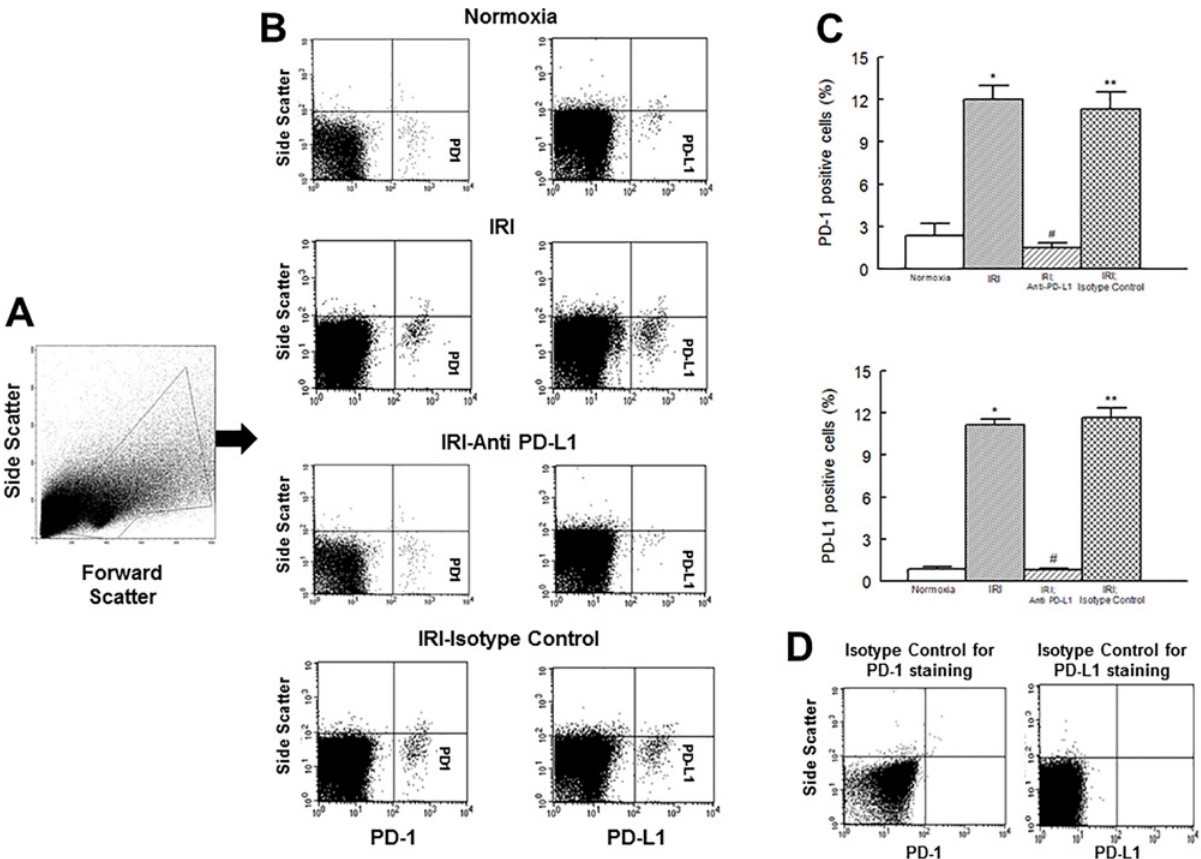
Fig 1. Flow cytometry profile of cardiac cell preparations outlining gated events is shown under panel A. Representative flow cytometry dot plots, under panel B, show increased expression of PD-1 and PD-L1 in cardiac cell preparations of ischemic-reperfused hearts compared to their normoxic controls, effects which were reversed by anti-PD-L1 antibody, but not by isotype matching antibody, treatment. Under panel C, bar graphs show percent of cells which were positive for either PD-1 or PD-L1; data are means ± SEM; n = 6 hearts/group for normoxic control, IRI and IRI; Anti-PD-L1 and n = 4 hearts for IRI; isotype matching control. Also shown under panel D are representative plots of staining isotype controls from FACS analysis for PD-1 and PD-L1 for gating purpose. IRI: Ischemia Reperfusion Injury. * p < 0.05 compared to the normoxic group. ** p < 0.05 compared to normoxia or IRI; Anti-PD-L1 group. # p < 0.05 compared to IRI or IRI; isotype control